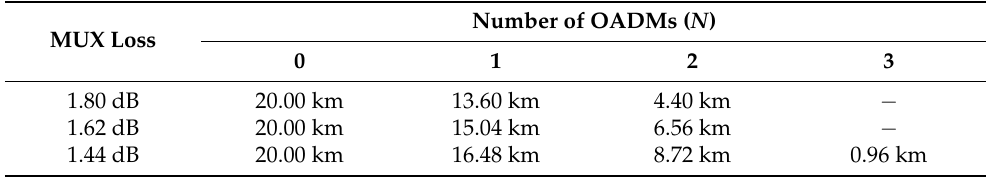
Table 2. Transmission distance L as a function of MUX loss and number of installed